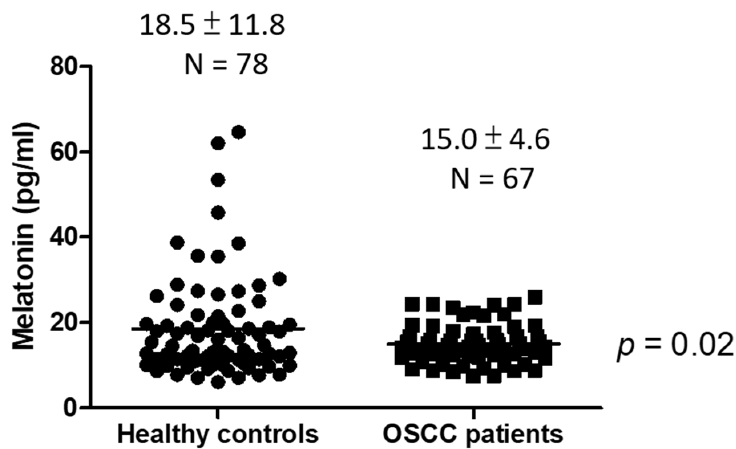
Figure 1. Serum melatonin levels in healthy controls and OSCC patients.